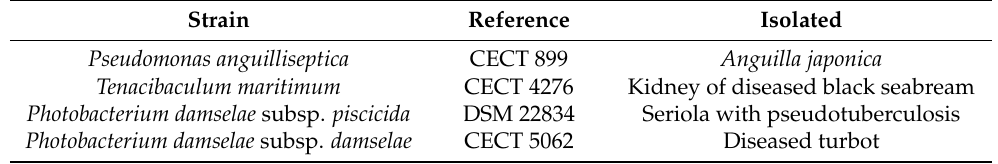
Photobacterium damselae subsp. damselae CECT 5062 Diseased